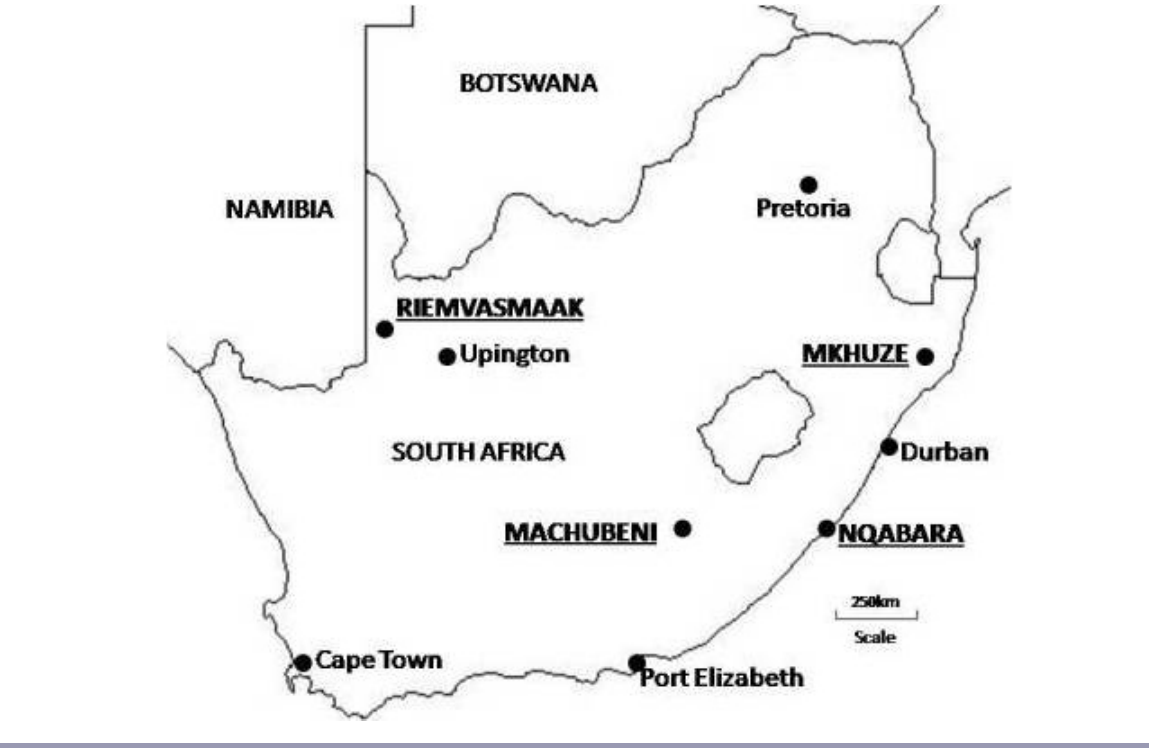
Fig. 1. Location of the four study sites in South Africa. Study sites are indicated by